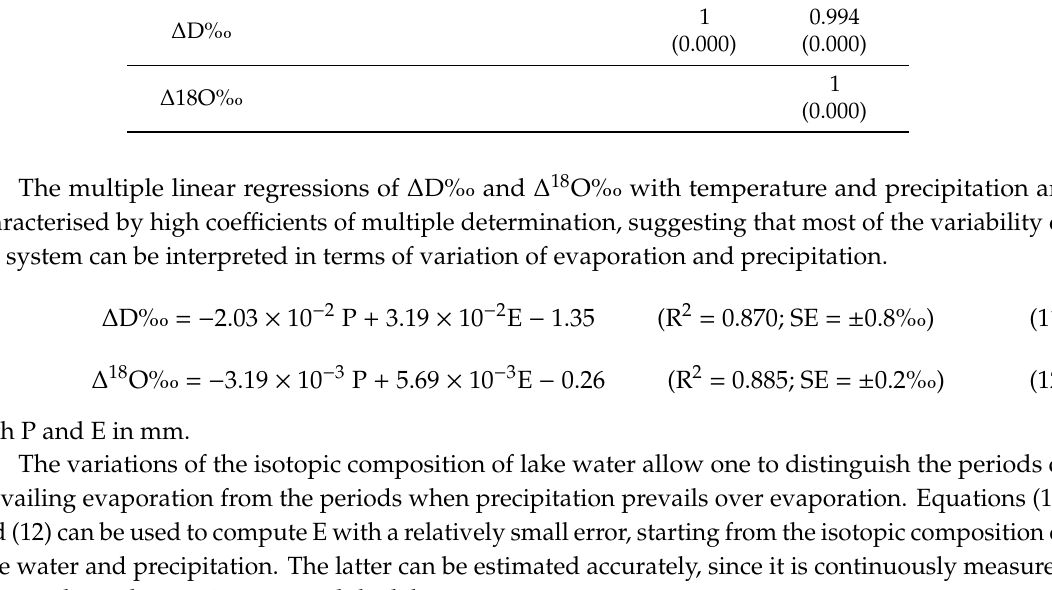
Table 2. Pearson correlation matrix of ∆ D% (cid:24) , ∆ 18 O% (cid:24) , and controlling variables temperature (t ◦ C), precipitation (P) and evaporation (E); for all pairs of data series, correlation coe ffi cients (r) and p -values (in brackets) are shown. Computations are based on Free Statistics Software v1.2.1 [57]. Variable t ( ◦ C) P (mm) E (mm) ∆ D% (cid:24) ∆ 18 O% (cid:24) − 0.352 1 0.913 t ( ◦ C) (0.000) (0.001) − 0.638 (0.000) (0.001) (0.000) (0.000) 1 0.870 0.877 E (mm) (0.000) (0.000) (0.000) 0.994 ∆ D% (cid:24) 1 (0.000) (0.000) ∆ 18O% (cid:24) 1